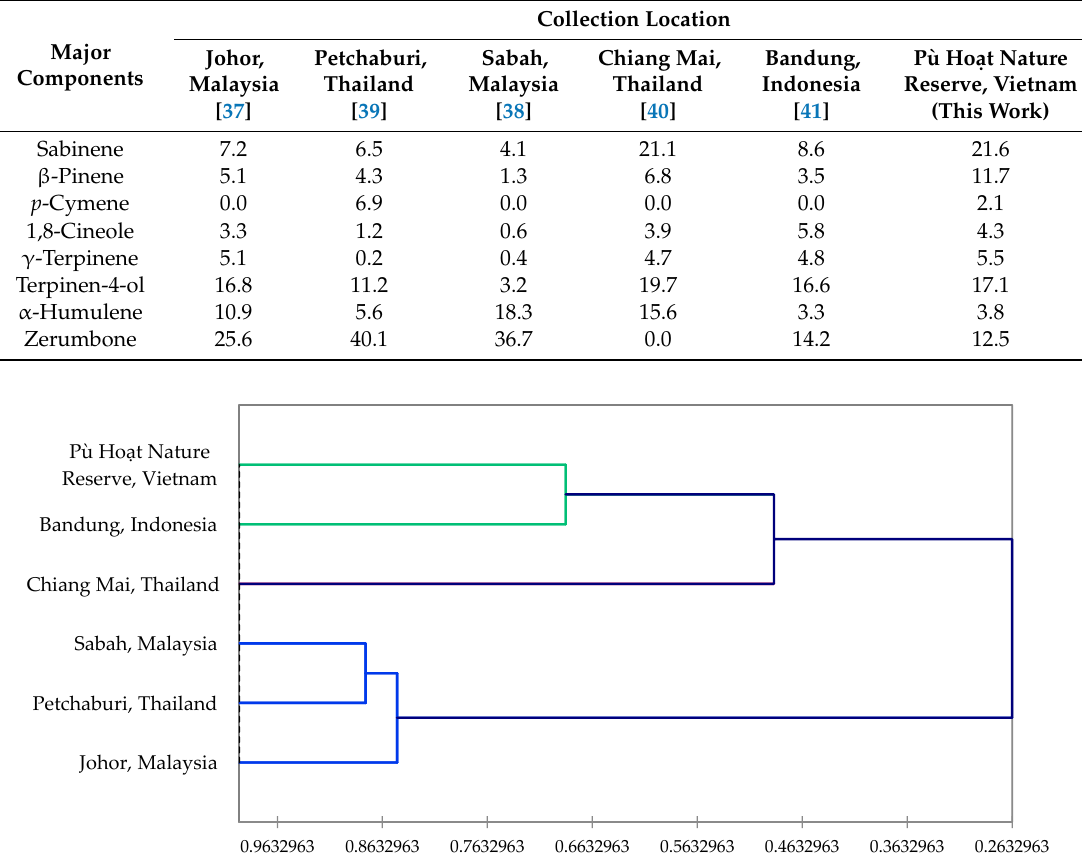
Table 3. Comparison of the major components of Zingiber ottensii rhizome essential oils from different geographical locations.